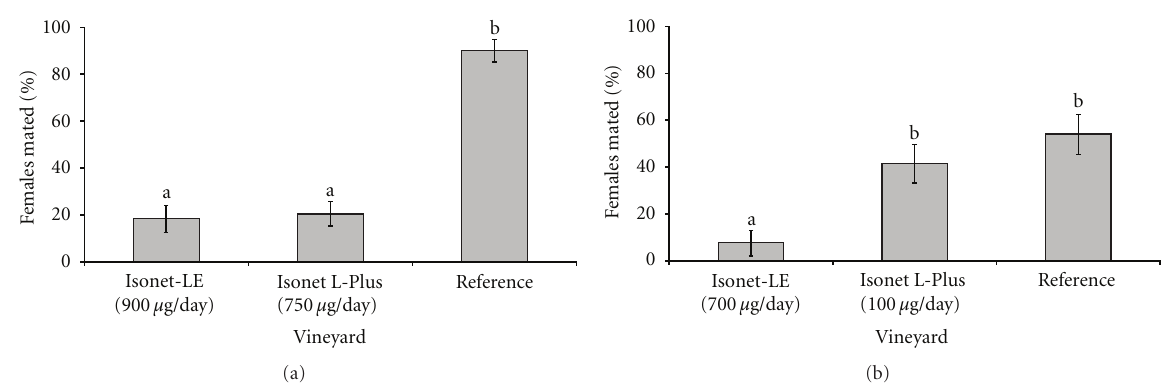
Figure 1: Percentage of mated (a) L. botrana and (b) E. ambiguella females in field cages (mesh size = 800 µ m) containing a pheromone dispenser. The notation µ g/day represents the approximate daily emission rate of pheromone dispensers for (a) L. botrana and (b) E. ambiguella . Pest control schemes with di ff erent letters are significantly di ff erent ( P < 0 . 05); data are untransformed; bars = 1